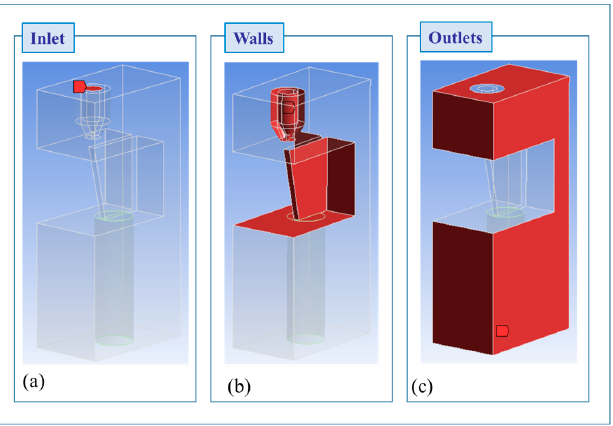
Figure 5. Computational domain showing boundary layers. ( a ) Inlet, ( b ) walls, and ( c )